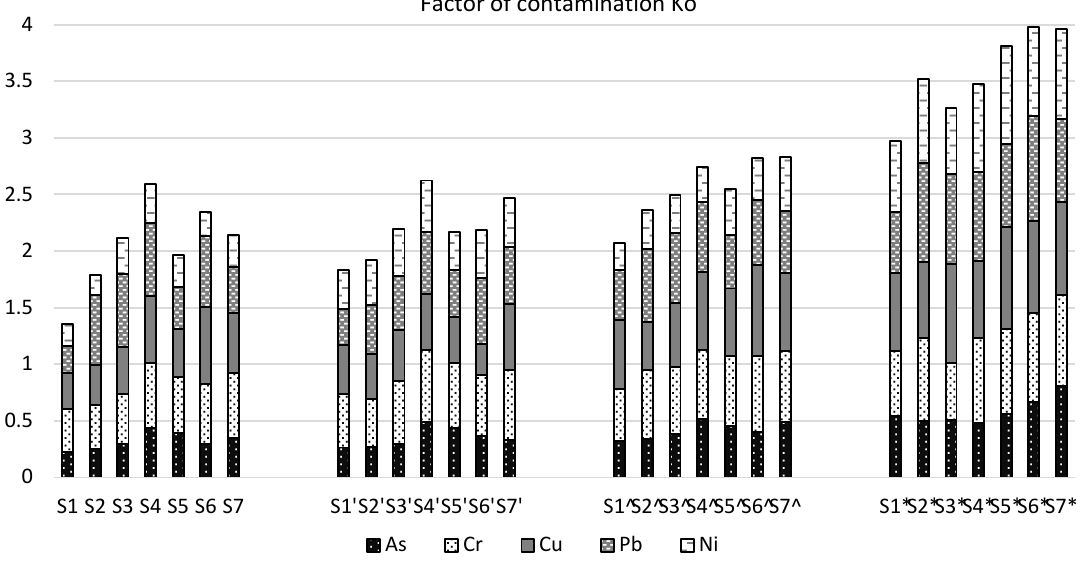
Figure 7. The factor of contamination Ko in different deep (S1, S2…S7—samples of 0–15 cm deep; S1’, S2’…S7’—samples of 15–30 cm deep; S1^, S2^…S7^—samples of 30–45 cm deep; S1*, S2*...S7*—samples of 45–60 cm deep).